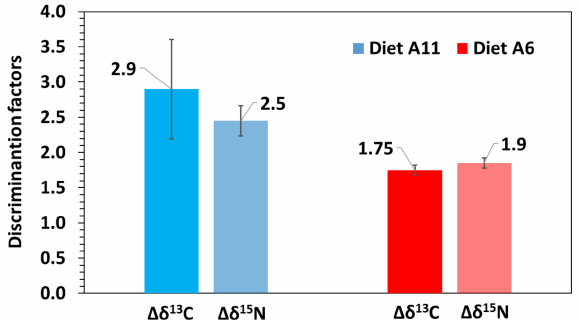
Figure 5. Average discrimination factors for δ 13 C and δ 15 N considering fitting models G and D in